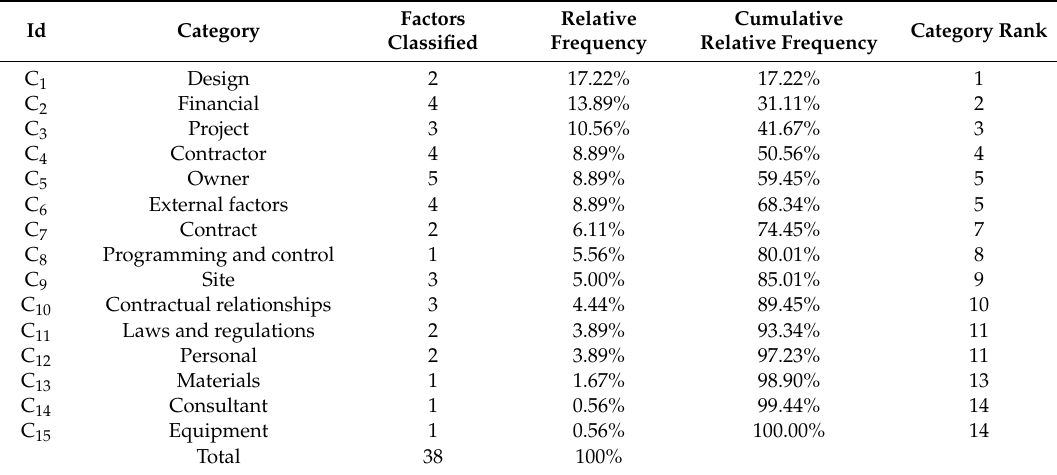
Table 6. Relative frequency by